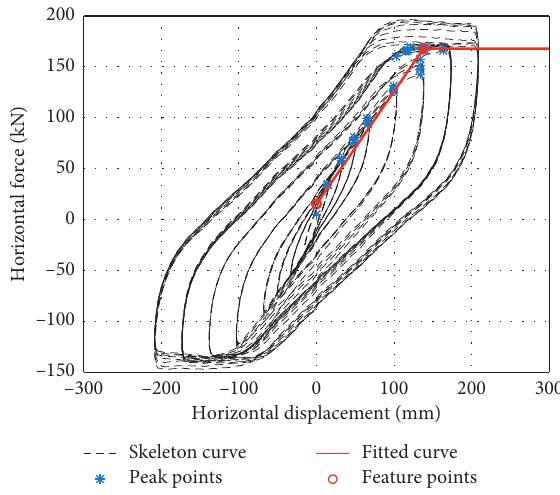
Figure 6: Specimen Y1-8-45 force-displacement